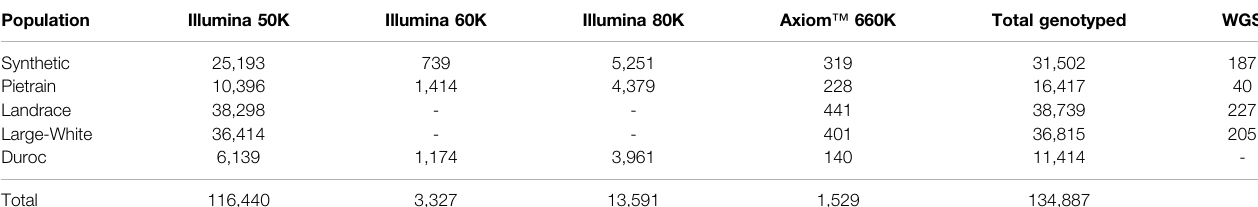
TABLE 2 | Number of genotyped and sequenced animals available with backfat measurements per population and per SNP